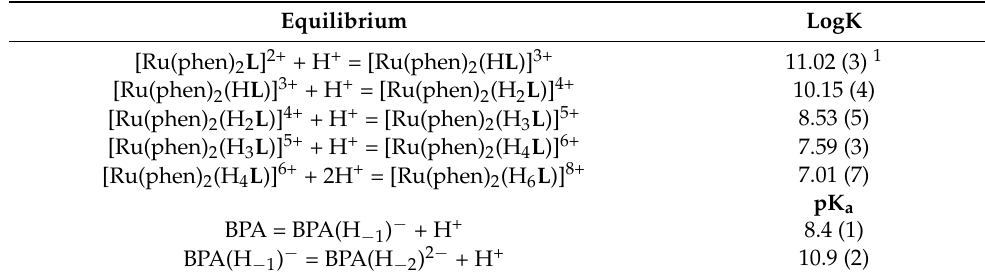
Table 1. Protonation constant of [Ru(phen) 2 L ] 2+ in NaCl 0.1 M aqueous solution and 298 K.